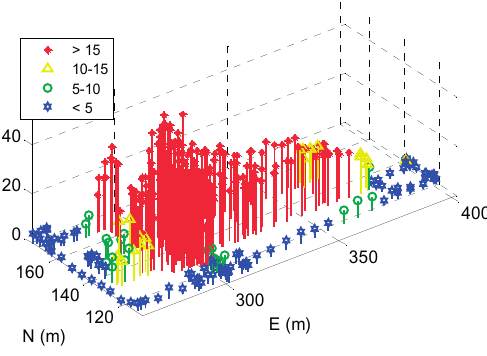
Figure 8. WiFi signal distribution in reference